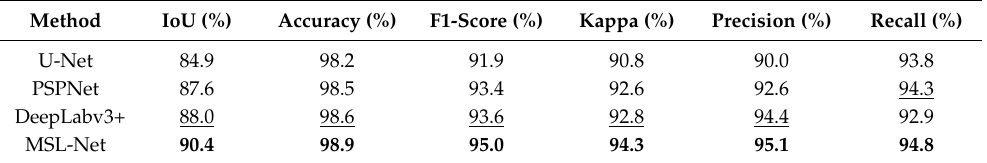
Table 5. Metrics produced on the WHU dataset. The highest scores are bolded; the second-highest scores are underlined.